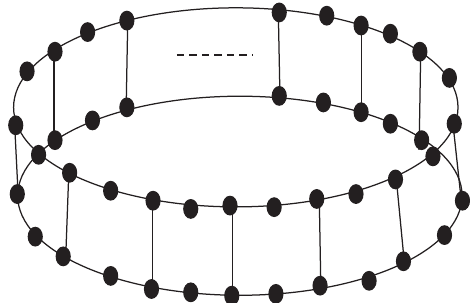
Figure 3: The zig-zag polyhex nanotube TUHC